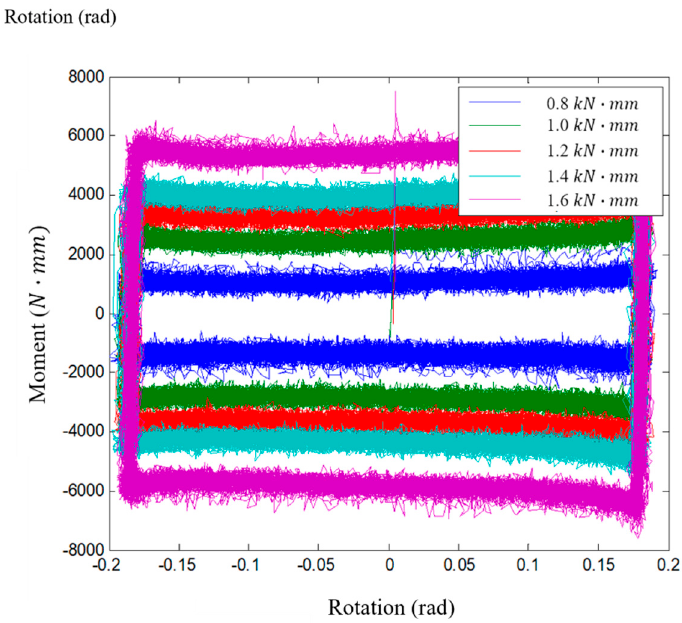
Figure 22. Relationship between Moment–Rotation Angle and Bolt tightening force.